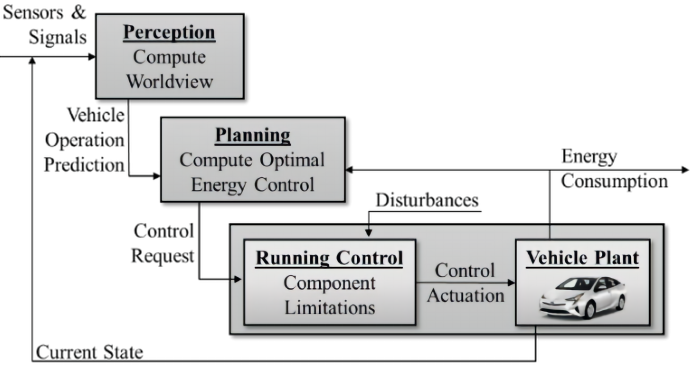
Figure 1. POEMS logic flow